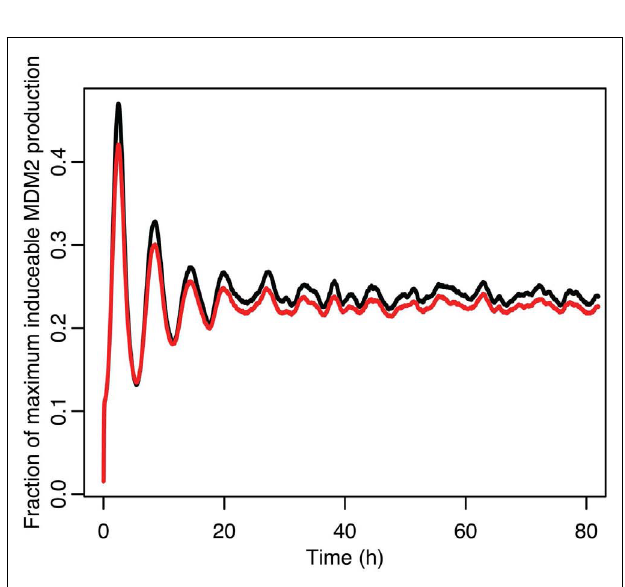
FIGURE 12 | Comparison of stochastic and deterministic models when the p53 production value is past the upper bifurcation point. (A) Shows the comparison for MDM2 with MDM2 from the deterministic model in red